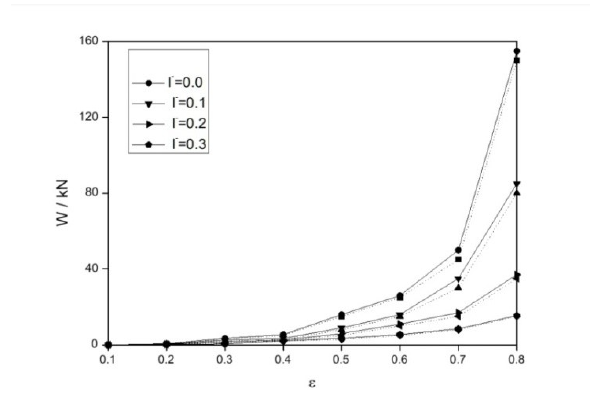
Fig. 2: Temperature contour in the centre plane at eccentricity ratio 0.3 and roughness parameter 0.1